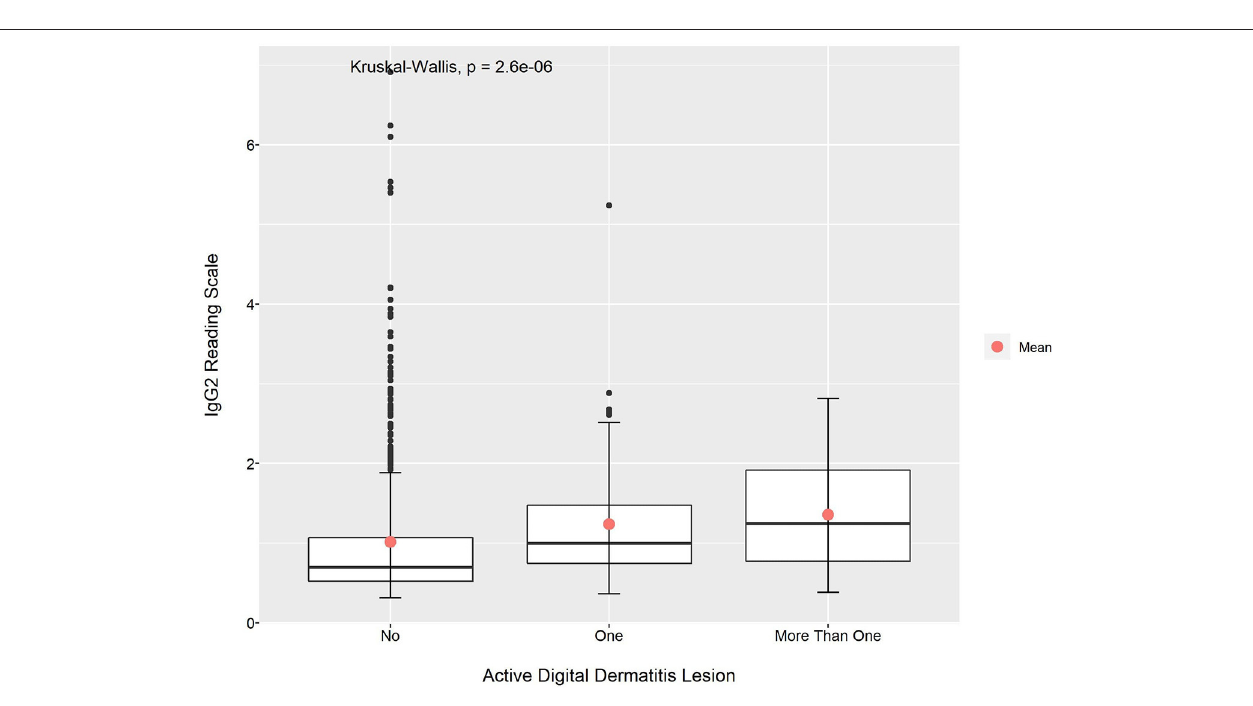
absorbance reading for IgG1 at pre calving, the later had higher mean absorbance readings for both IgG1 and IgG2 ( p <